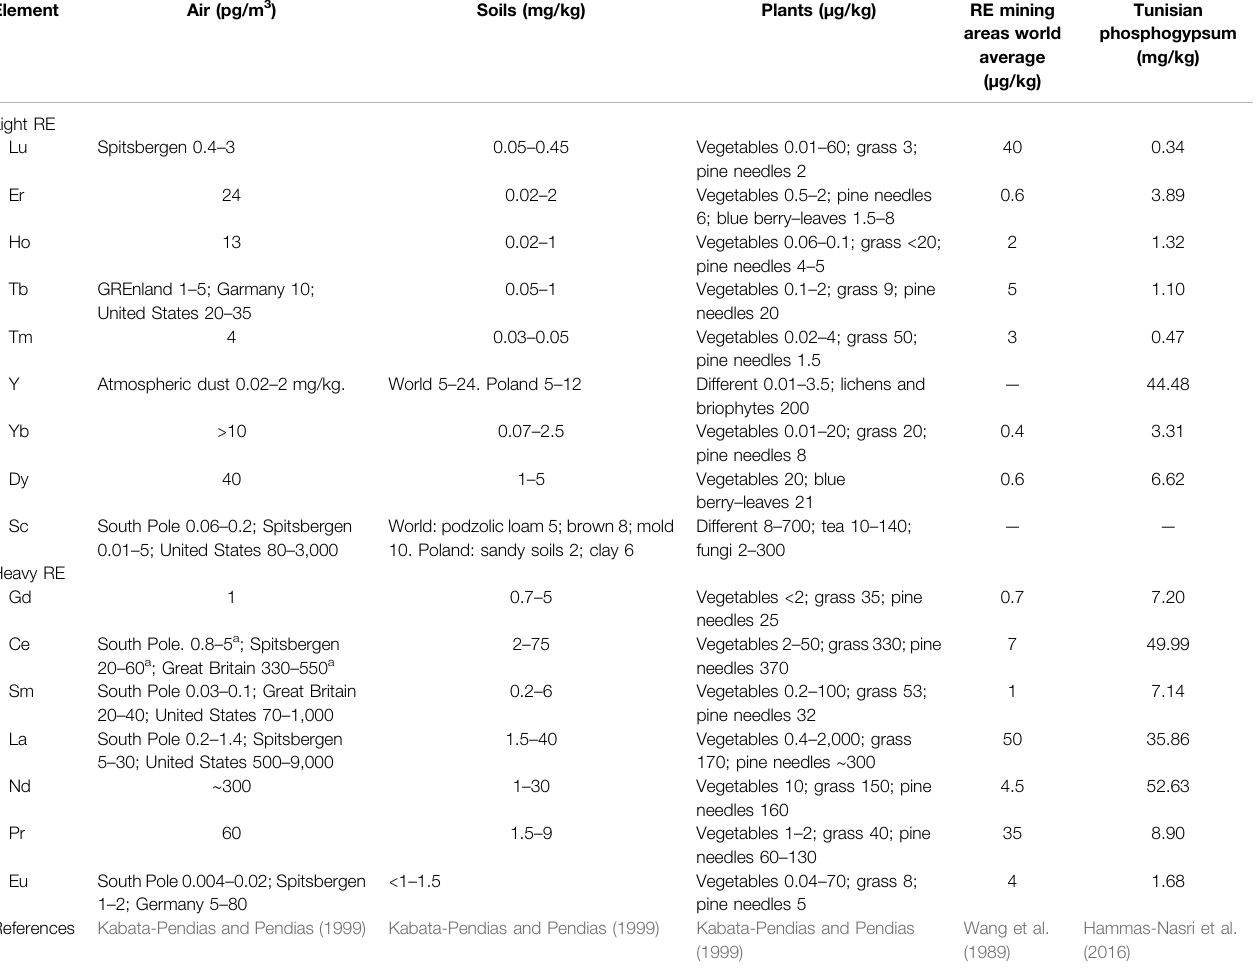
TABLE 3 | Concentration of rare earth elements (RE) in different components of the environment.